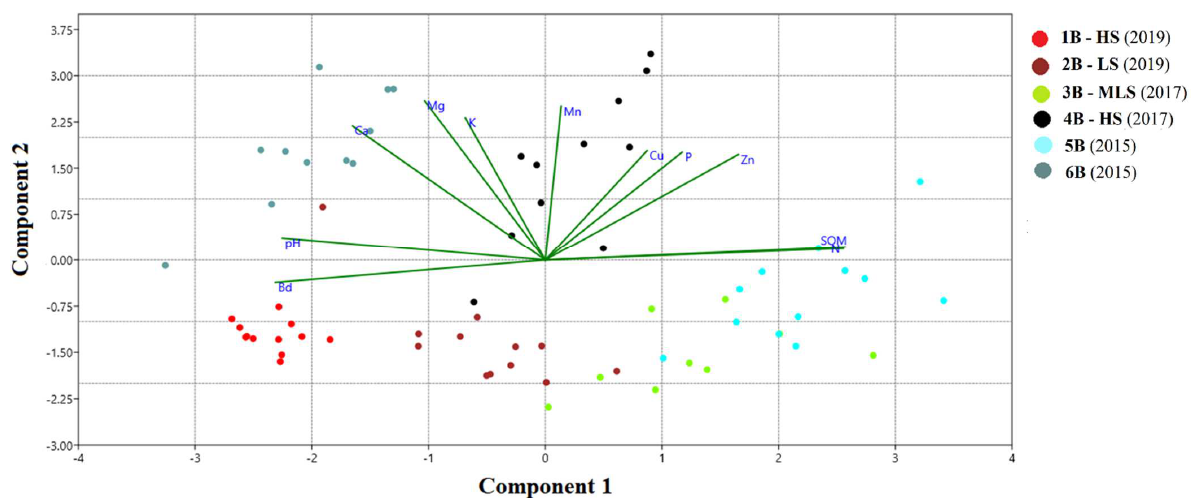
Figure 6. Orthogonal distribution of the Principal Component Analysis (PCA) of the parameters analyzed in burned HMs. The red circle represents the high severity fire of 2019 (1B-HS) and the brown circle the low severity fire of 2019 (2B-LS). The green circle is the moderate low severity fire of 2017 (3B-MLS) and the black circle is the high severity fire in 2017 (4B-HS). The bubble gum and lead-colored circles are the fires of the year 2015 where the severity is not known. Soil attributes include bulk density (Bd), organic matter (SOM); nitrogen (N); phosphorous (P); potassium (K), pH, calcium (Ca); magnesium (Mg), manganese (Mn), copper (Cu) and zinc (Zn).